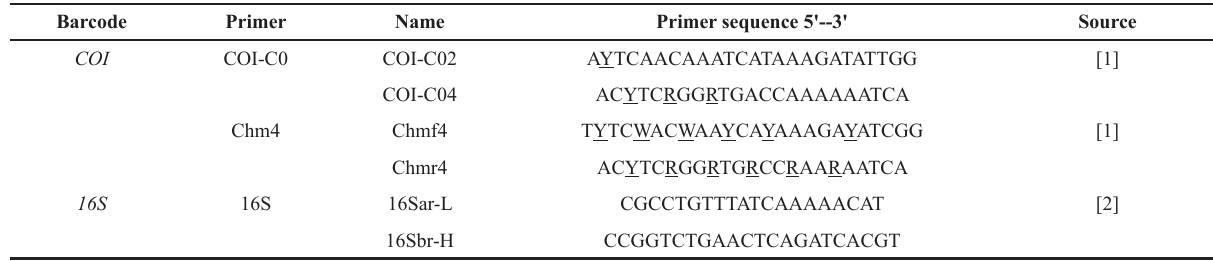
Table 1. Sequence information of universal PCR primers for COI and 16S . Base pairs underlined indicate 2-fold degenerate